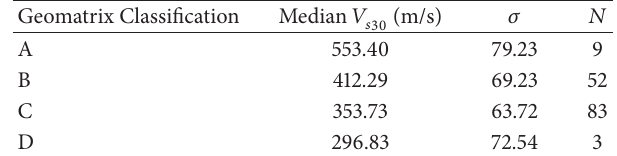
Table 5: Bias and standard deviation of the five other types of 𝑉 𝑠30 estimates relative to 𝑉 𝑠30